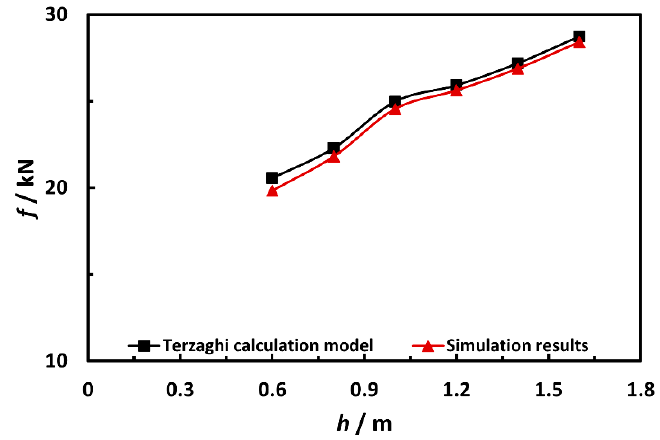
Figure 14. Validation of simulation results.